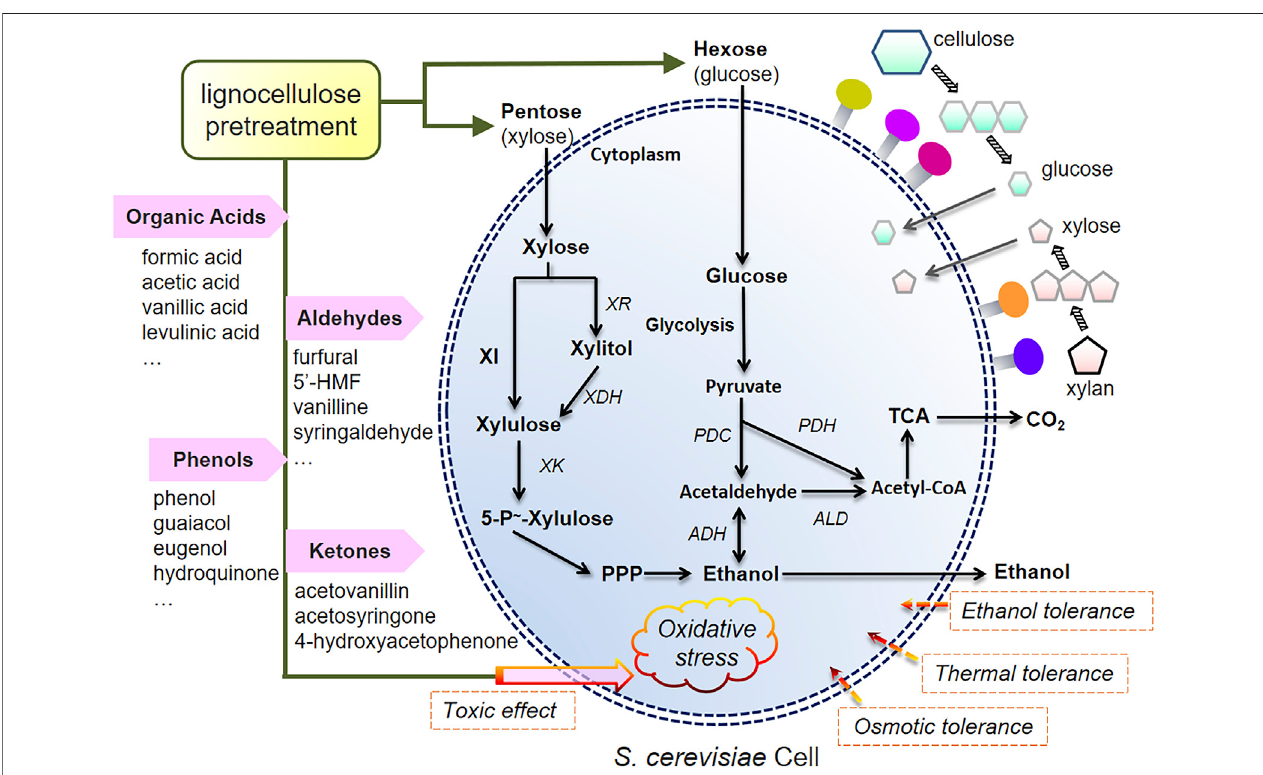
FIGURE 1 | Stress tolerance in S. cerevisiae against pretreated hydrolysate inhibitors and metabolic pathways of xylose-fermenting or CBP strains during lignocellulosic ethanol fermentation.